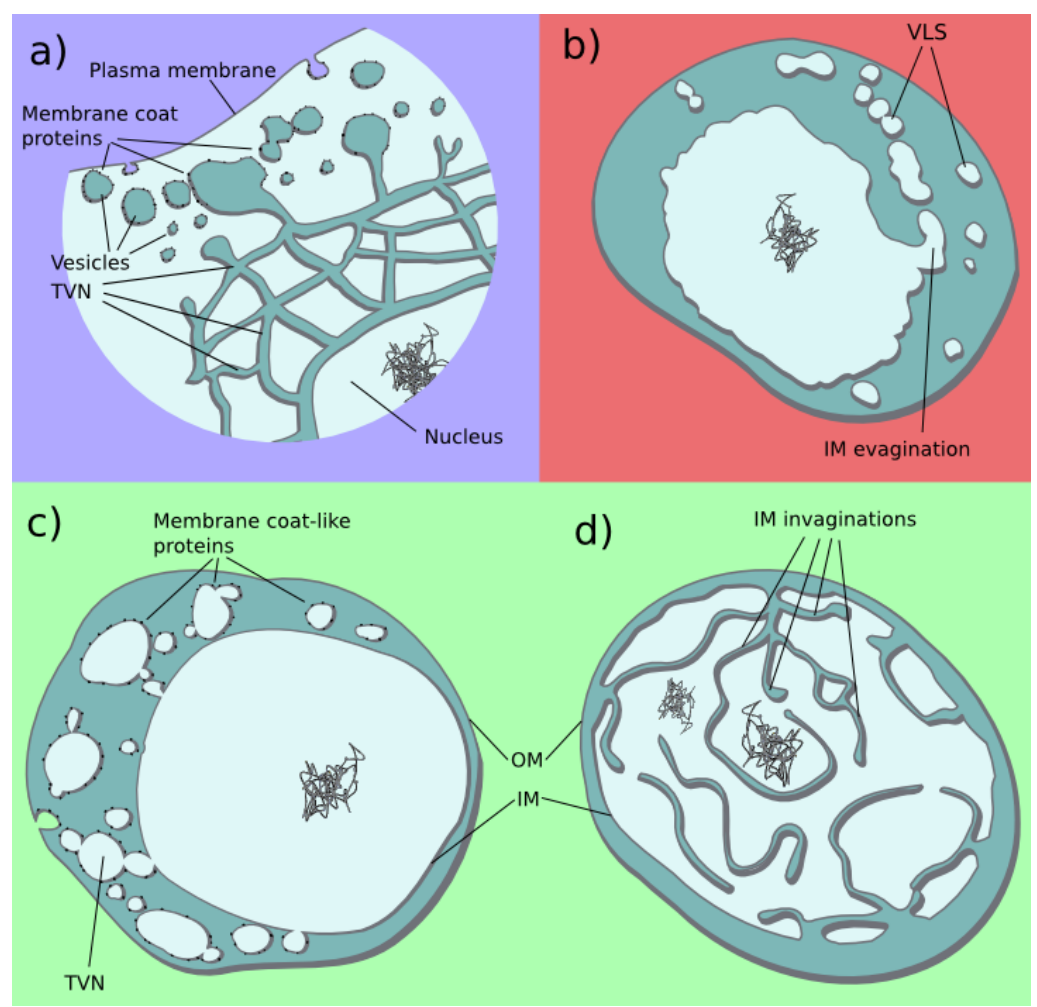
Figure 2. Various types of TVNs in the three domains of life. Schematic of various endomembrane systems are presented. ( A ) Giardia lamblia is representative of atypical eukaryotic ES that might be organized as TVNs (only a portion of a cell is represented). Endocytosed proteins are degraded by proteases in the TVN. Membrane fusions between vesicles and the plasma membrane, between vesicles and the TVN are dynamic, redraw based on [42]; ( B ) Ignicoccus hospitalis with periplasmic IM evaginations, tubules and vesicles-like structures (VSL) are most likely connected, inspired by [36]; ( C , D ) Gemmata obscuriglobus cellular membrane organization; ( C ) Cell type with periplasmic TVN, internalized proteins are possibly captured by protein-coated vesicles, from [34]; ( D ) Cell type with cytoplasmic membrane invaginations, based on [33]. Membrane coat-like proteins are represented by dark dots, only in ( A ) and ( C ). DNA is represented as string. Background is blue for eukaryote, red for archaea and green for